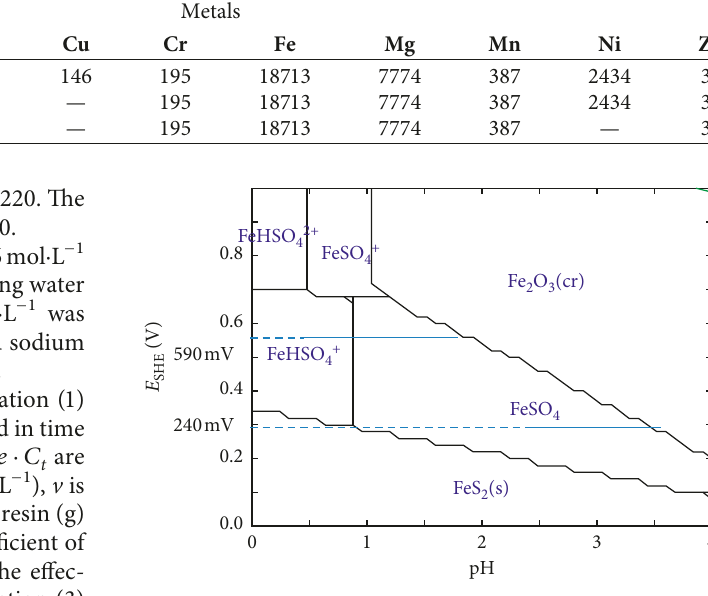
Table 1: Metals concentration for batch experiments for Solution 1, Solution 2, and Solution 3 in mg